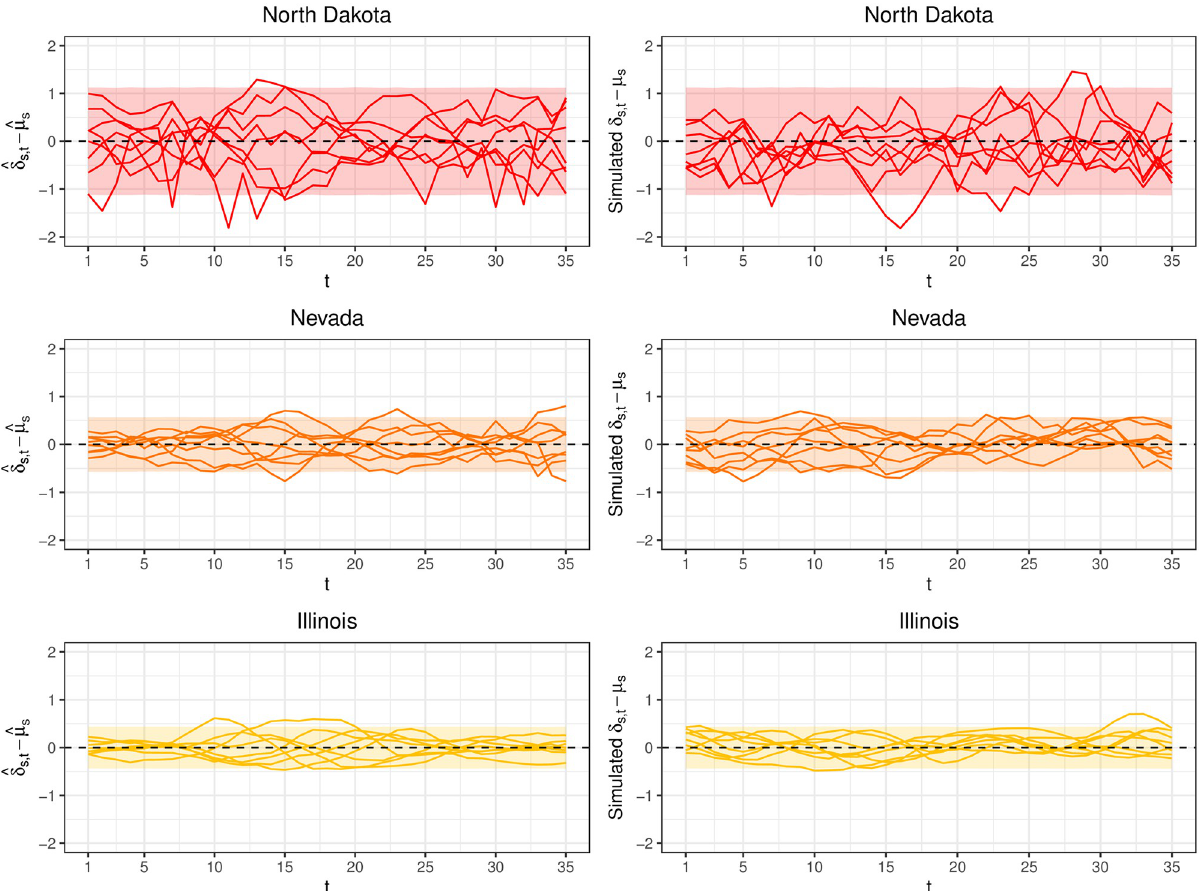
Fig 9. (Left column) The quantities ^ δ (cid:0) ^ m 1 estimated from training data. Each line corresponds to a season s . The ribbon is the 95% confidence band s s from the fitted multivariate normal model. (Right column) The lines are realizations drawn from MVN ð 0 ; ^ Σ Þ . The ribbon is the same 95% confidence band as in the left column for ease of comparison. Good visual agreement is seen between the simulated δ s − μ s 1 and ^ δ data, suggesting the multivariate normal distribution is able to capture heterogenous discrepancy characteristics across